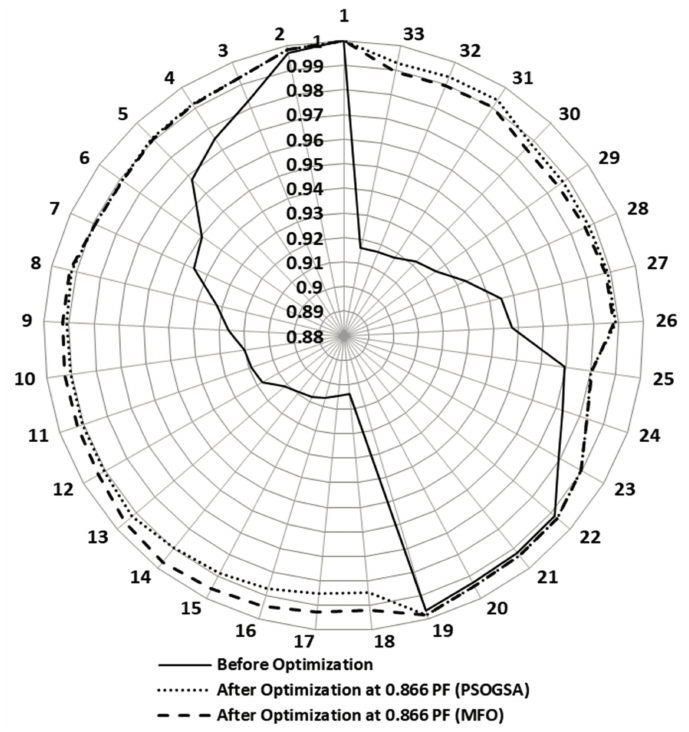
Figure 15. The impact of compensated devices on voltage profile for 33-bus IEEE system at 0.866